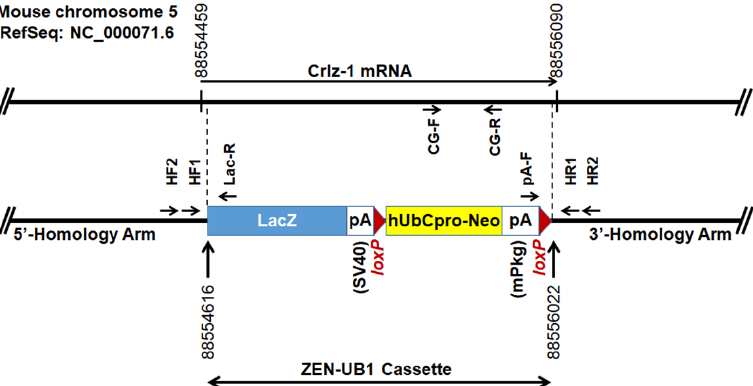
Figure 1. The map of ZEN-UB1 cassette-targeted Crlz-1 KO locus is schematically drawn at the bottom, with that of wild-type Crlz-1 locus aligned at the top, including the sites of eight arrowed primers for genotyping PCR. The numbers on the wild-type locus map at the top indicate the Crlz-1 transcription start and stop sites, whereas the ones on the targeted locus map at the bottom indicate the Crlz-1 deletion points. The numbers are based on the RefSeq of NC_000071.6 in the mouse chromosome 5.